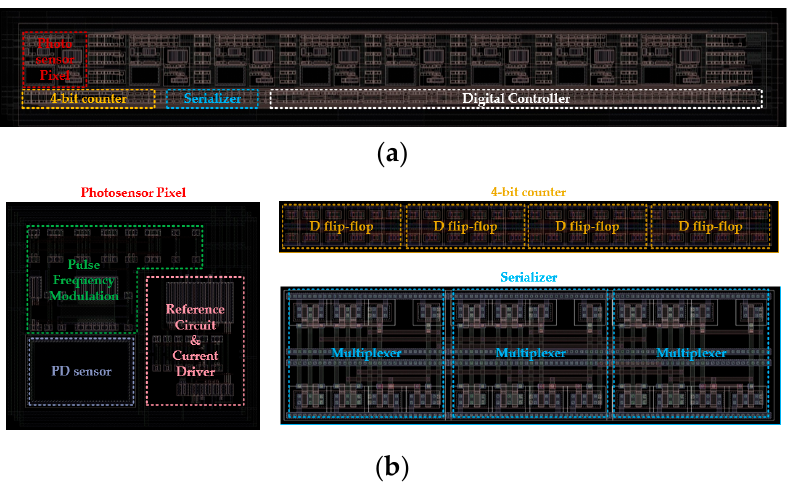
Figure 8. A footprint of the proposed 8-pixel circuit. ( a ) Full system with 8-pixel circuit that occu- pies 700 μ m × 68 μ m. ( b ) Footprint of each block that makes up the entire system. Single photo- sensor pixel area is 65 μ m × 55 μ m; 4-bit counter area is 145 μ m × 10 μ m. Serializer area is 45 μ m × 10 μ m.